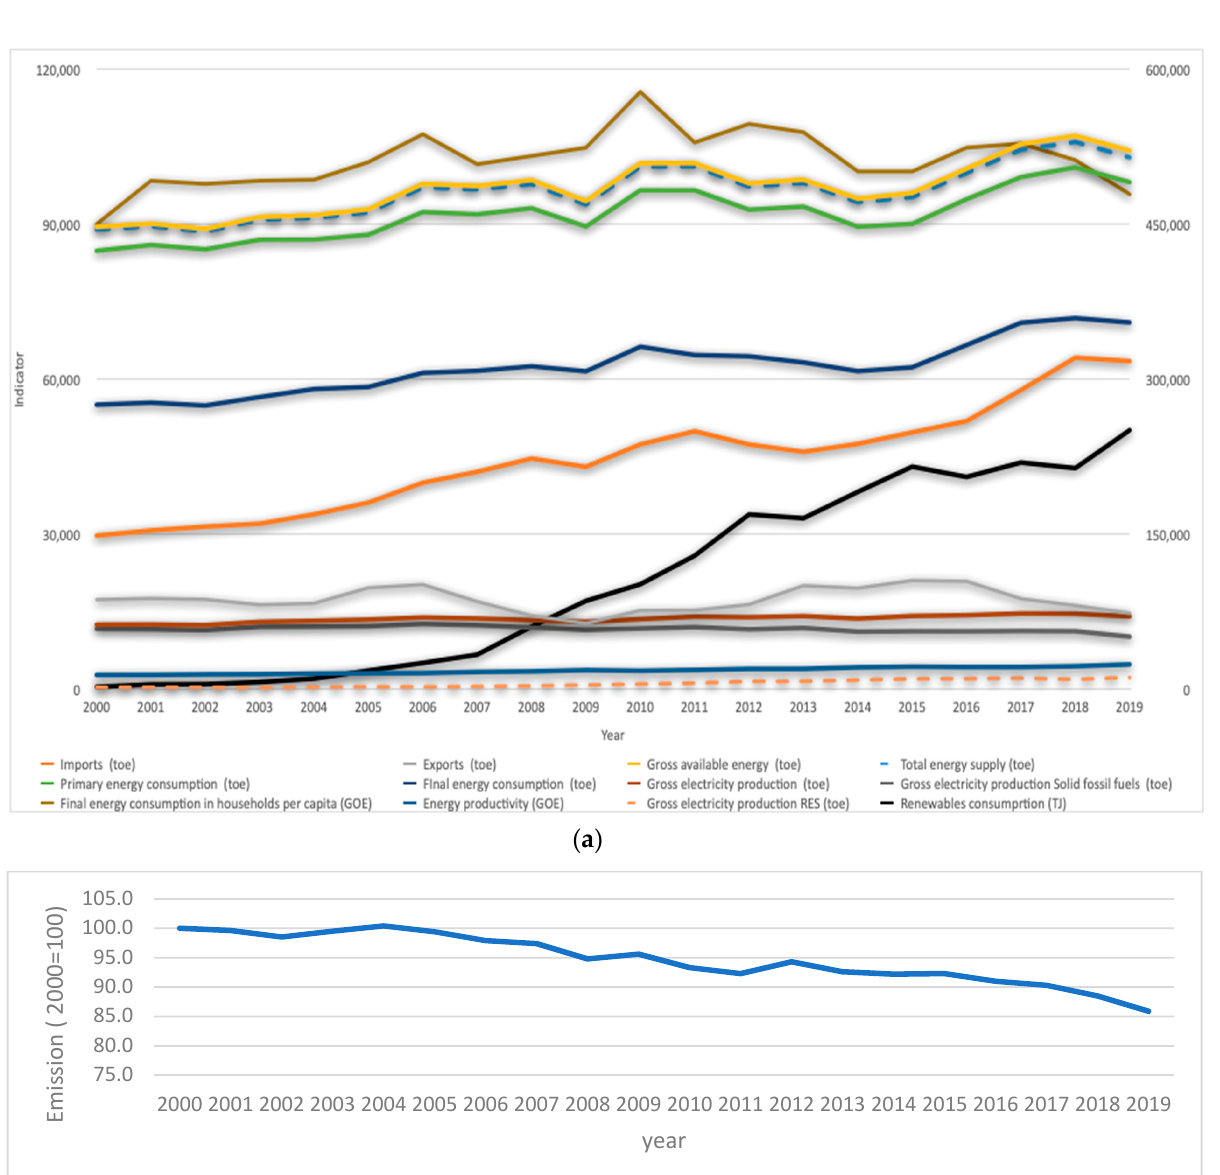
Figure 1. Indicators introduced into the ARMAX model ( a ); greenhouse gas emissions intensity of energy consumption 2000 = 100 ( b ) [17].